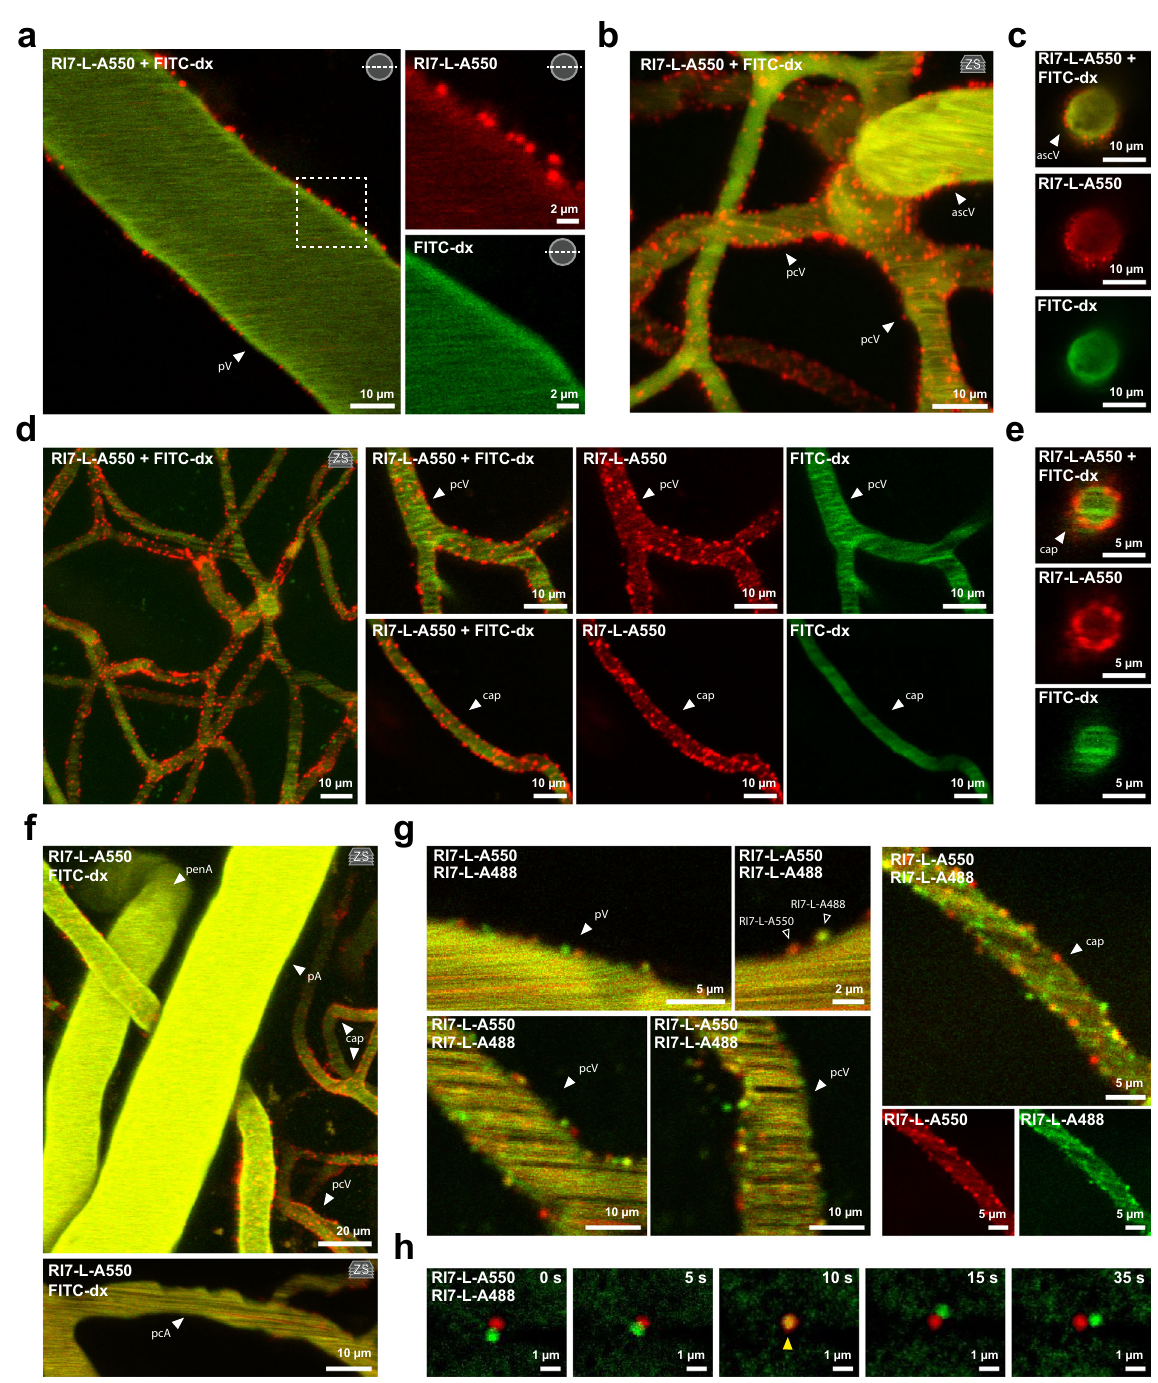
Fig. 2 Robust association of nanoparticles to the BBB. a – e Two-photon in vivo images of RI7-L-A550 nanoparticles (red) 2h after injection into the circulation. Co-injected FITC-dx (green) delineates vessel lumen. Nanoparticles readily associate to vessel walls at pial venules, ascending venules, post-capillary venules, and capillaries. f In contrast to venules and capillaries, nanoparticles do not associate to arterial branches of the brain microvasculature. g Co-injection of both RI7-L-A550 and RI7-L-A488 reveals discrete punctae of both variants of nanoparticles at the vessel walls. h Time-lapse images of laser-extravasated nanoparticles in brain parenchyma. The presence of merged fl uorescence signal is because of the fl uorescence signal overlap when nanoparticles are in proximity to each other (arrowhead) and not due to nanoparticle fusion or exchange of fl uorophores. All panels: pV pial venule, ascV ascending venule, pcV post-capillary venule, cap capillaries, penA penetrating arteriole, pA pial arteriole. ‘ zs ’ inset indicates Z-stack maximum intensity the 10 most motile nanoparticles that remained in the imaging with a vessel symmetry axis and blood fl ow direction, both plane from each analyzed vessel segment. The traces were aligned independent from the vessel curvature (Fig. 5c). To avoid to the point of origin (Fig. 5c), and to avoid underestimation of underestimation of the movement along the vessel v axis, we movement in planar ( x,y ) coordinates, especially in vessels with a omitted ascending venules because of their high-angle orientation small circumference, we projected each trace to a vector V aligned to the imaging plane (see “ Methods ” ).